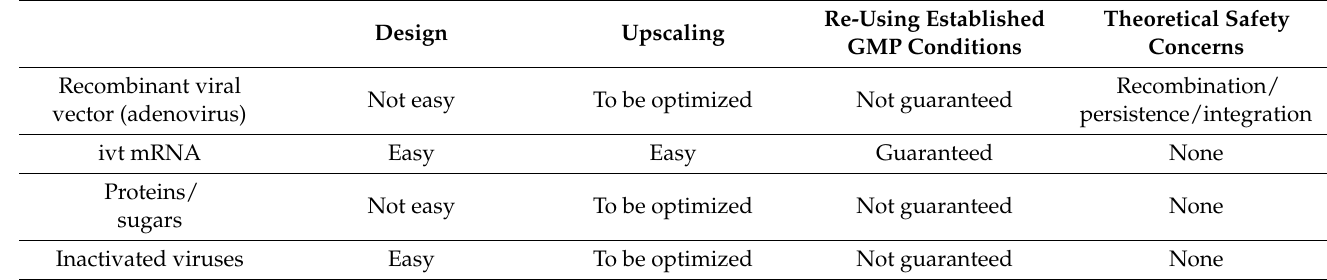
Table 1. Advantages and disadvantages of selected vaccine platforms.